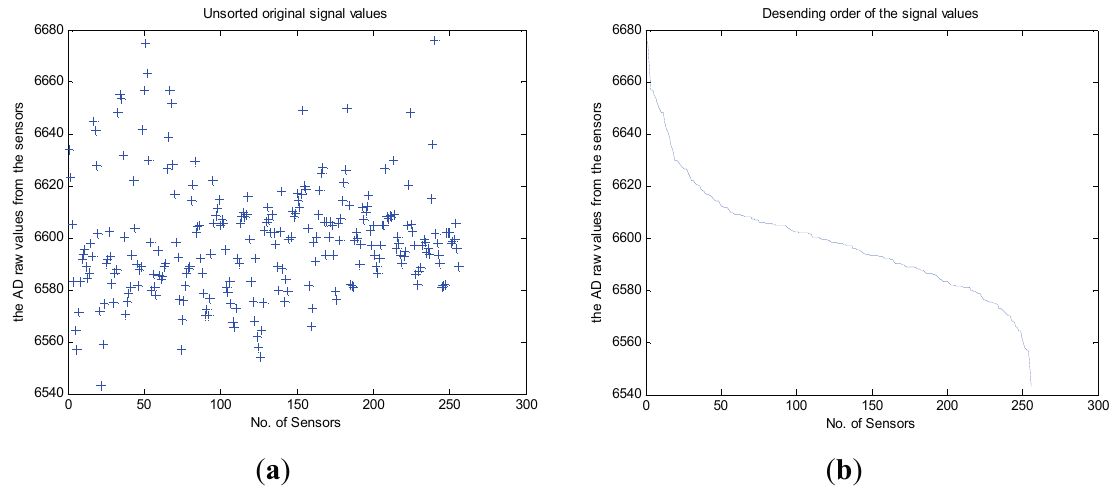
Figure 5 . ( a ) Unsorted monitored data values during preprocessing; ( b ) sorted monitored data values during